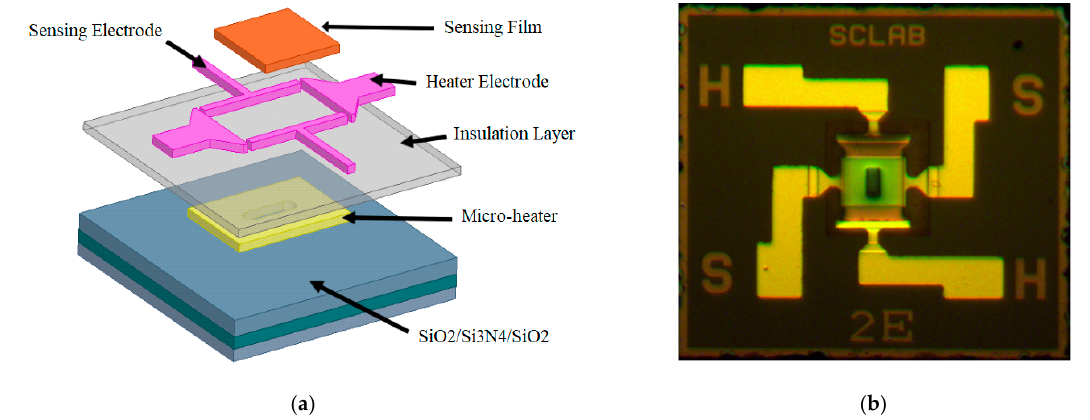
Figure 4. ( a ) MEMS-based microheater structure and ( b ) image of MEMS-based microheater.